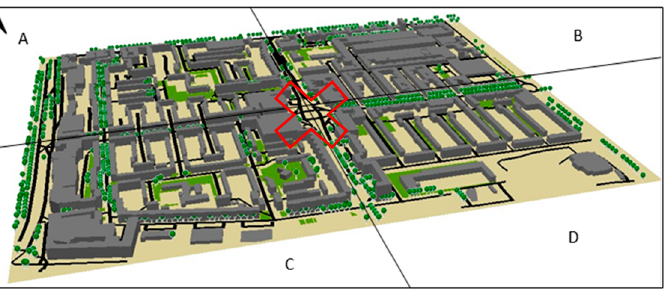
Figure 3. Alvalade neighborhood. X represents the central square one can find in Alvalade neighborhood. (A–D) refer to the sectors mentioned in the text.